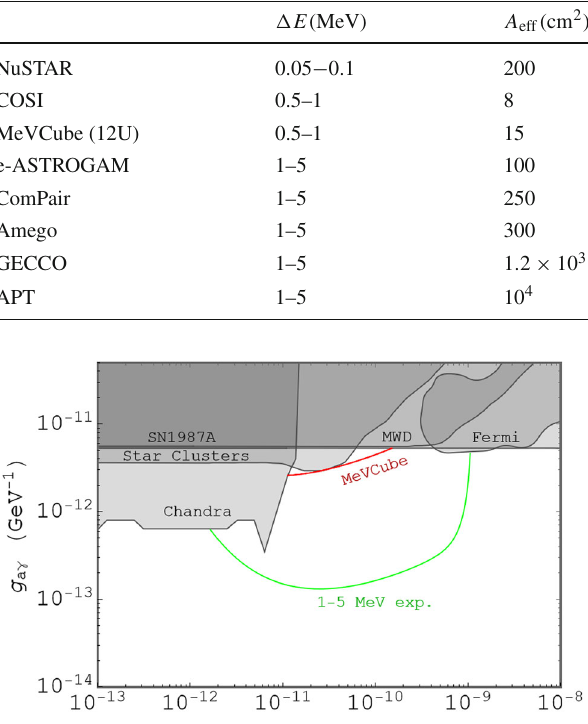
Table 2 Optimal energy range, (cid:12) E , for the detection of ν BADM for each experiment discussed in the text. The average effective area, A eff , in the chosen energy bin is also shown